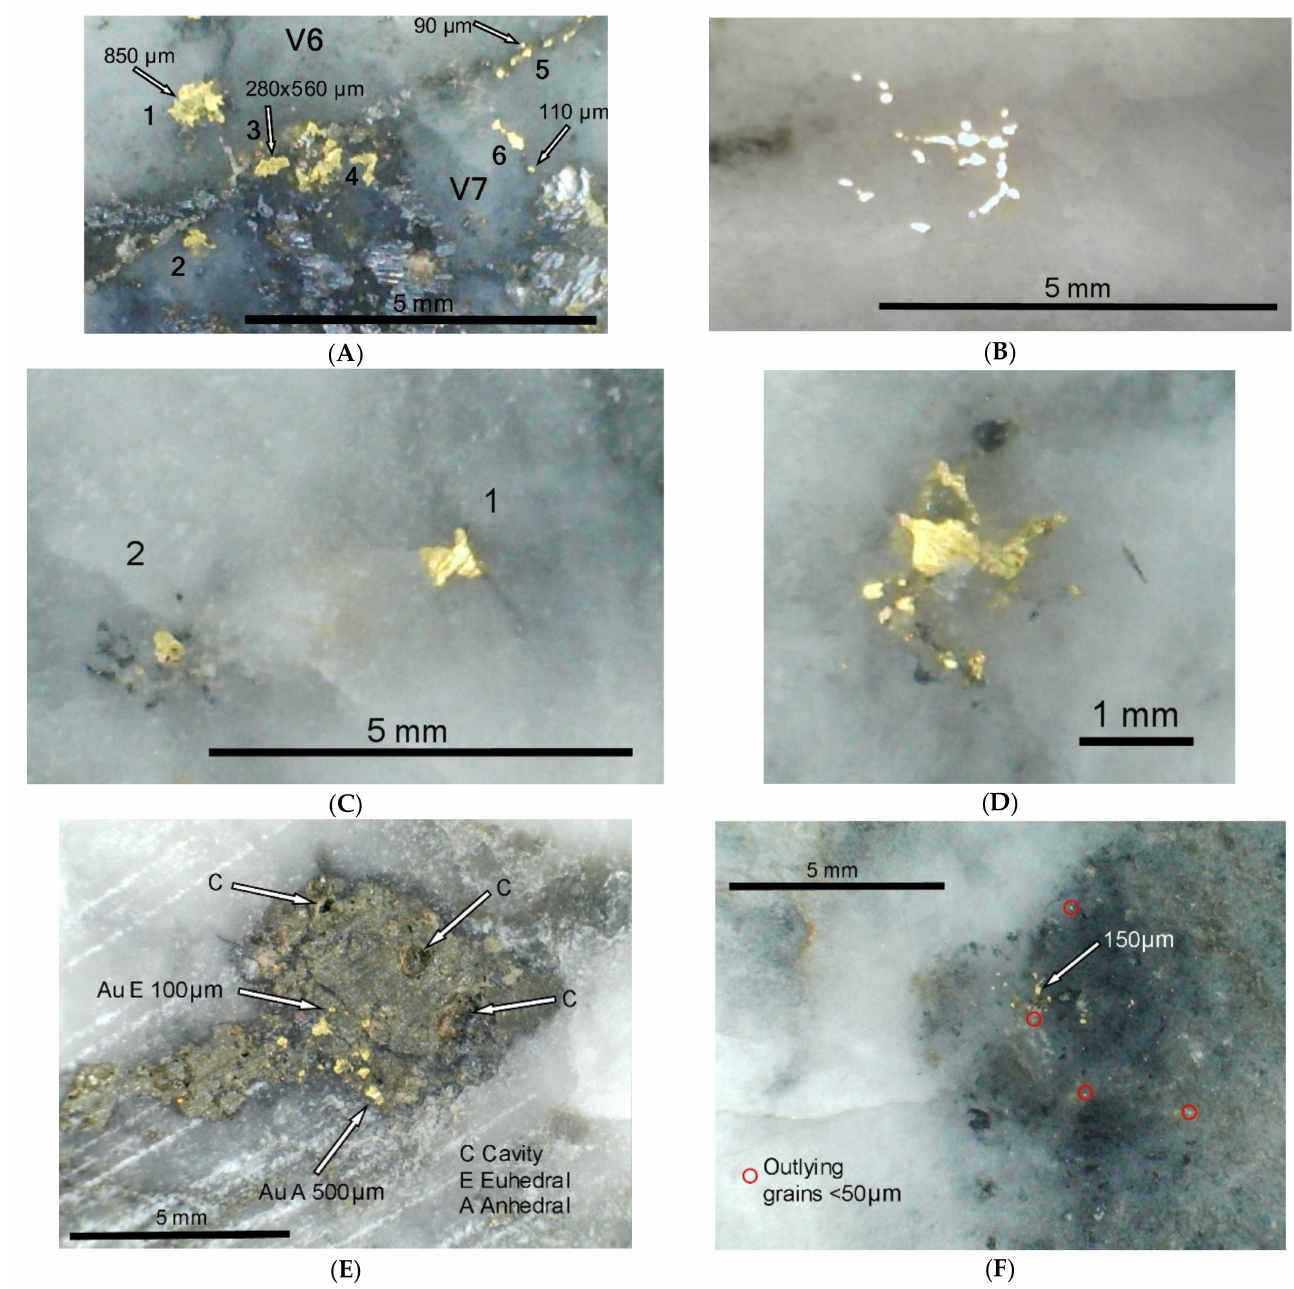
Figure 11. Aspects of gold occurrence. ( A ) Sample B5, gold occurrence at the V6/7 boundary in Figure 9. 1, Gold with frilled margin in quartz; 2, possible euhedral particles in quartz; 3, scalloped gold grain on V6/7 boundary; 4, gold particles in galena aggregate; 5, string of small particles along V6/7 boundary; 6 string of gold particles along possible quartz-quartz grain boundary. ( B ) Sample D2, gold particles and sheets inferred to follow quartz grain boundaries. ( C ) Sample B6, gold isolated in quartz. 1, gold moulded on quartz terminations; 2 gold with rounded form. ( D ) Sample D2, small (2 mm) gold cluster. ( E ) Sample B6, gold cluster (3 mm) in part of sulphide pseudomorph. Gold particles range from 100–500 µ m. ( F ) Sample B5, cluster of small gold particles in quartz with mudstone debris. Core of cluster 2 mm. Particles range from <50–150 µ